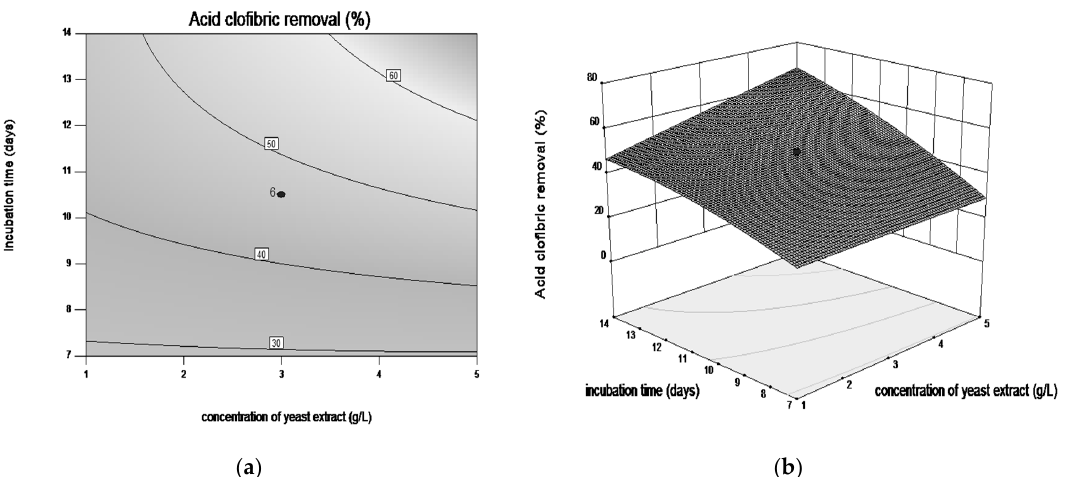
Figure 5. Contour plot ( a ) and three-dimensional surface plot ( b ) showing the effect between incubation time and concentration of yeast extract on CLF biodegradation by Trametes pubescens .